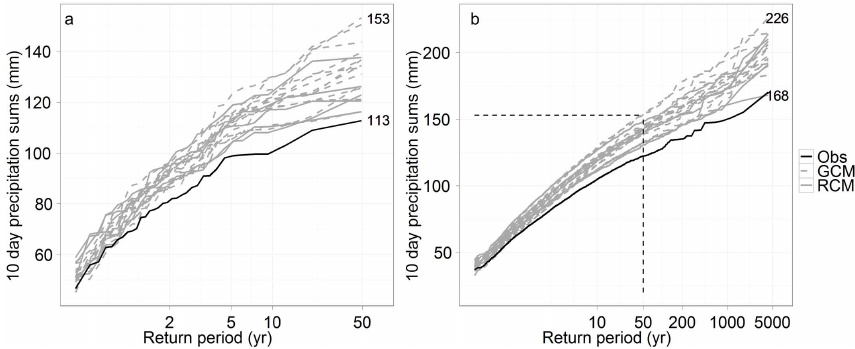
Fig. 5. Gumbel plots of the maximum 10-day basin-average precipitation in winter (October–March) for the future climate (end of the 21st century) from the short time series of transformed observations – 35yr, panel (a) – and those from the long time series of transformed resampled observations – 3000yr, panel (b) . The black line represents the maximum 10-day basin average precipitation sums in the (resam- pled) observations; the dashed grey lines refer to transformed observations based on the 13 GCM simulations and the solid grey lines refer to the 5 RCM simulations. The horizontal and vertical dashed black lines in the right panel mark the extension of the left panel.